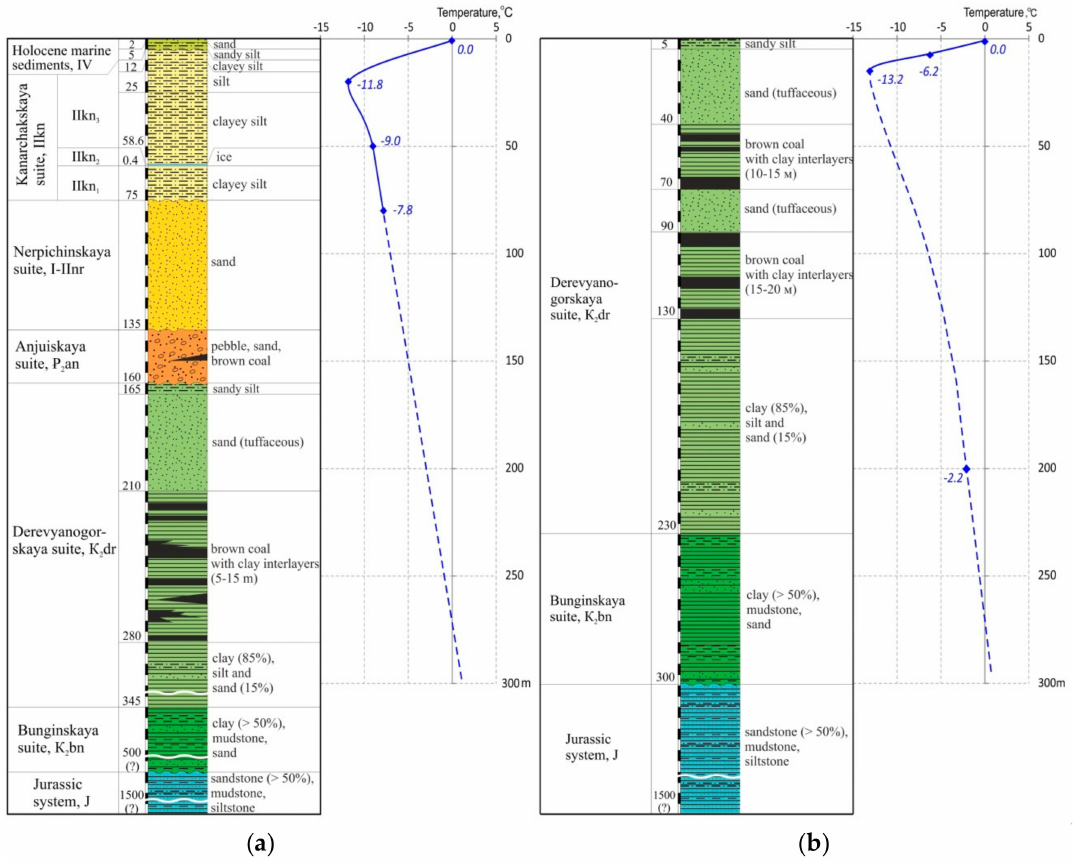
Figure 4. The geological sections per data on boreholes c-B ( a ), c-A ( b ) (Figure 1) and the State geological map of the Russian Federation [55] and the temperature